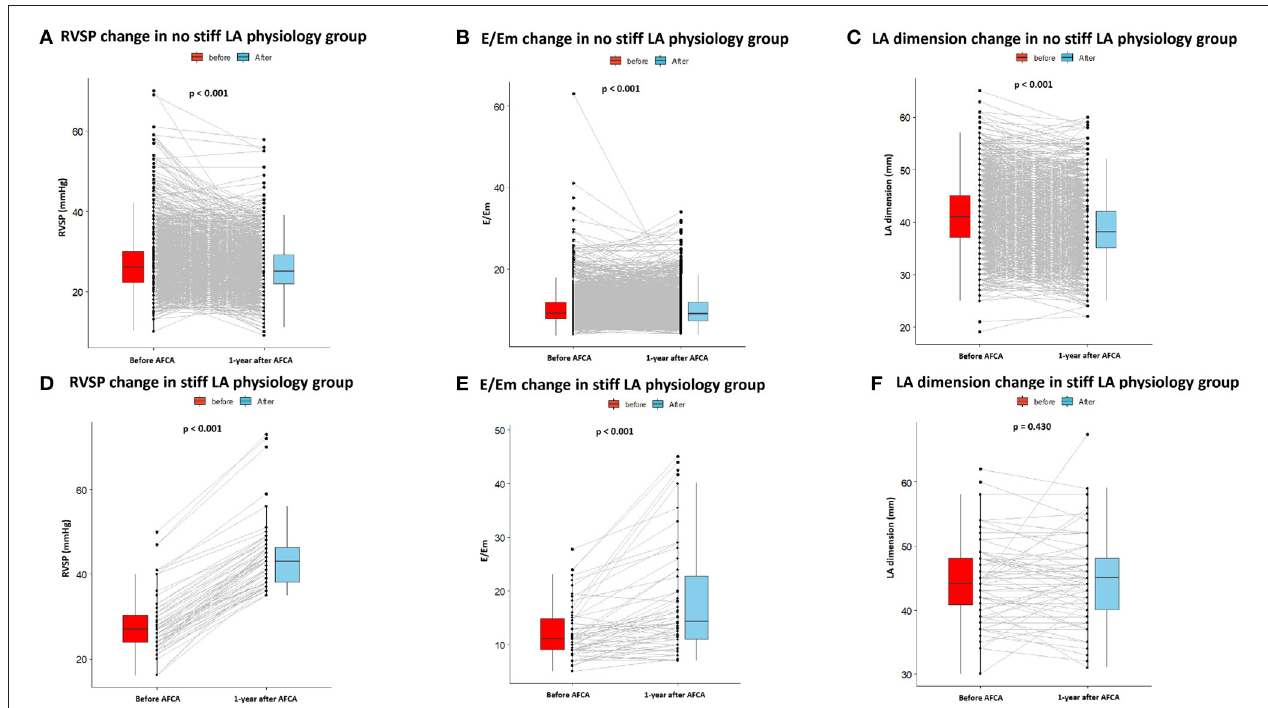
FIGURE 3 | Changes in echocardiography parameters before and 1 year after AFCA depending on the development of stiff LA physiology. In patients without stiff LA physiology, RVSP (A) , E/Em (B) , and LA dimension (C) significantly decreased 1 year after AFCA. In contrast, in patients with stiff LA physiology, RVSP (D) and E/Em (E) increased, and LA dimension (F) did not change. E/Em, the ratio of the peak mitral flow velocity of the early rapid filling to the early diastolic velocity of the mitral annulus; LA, left atrial or left atrium; RVSP, right ventricular systolic